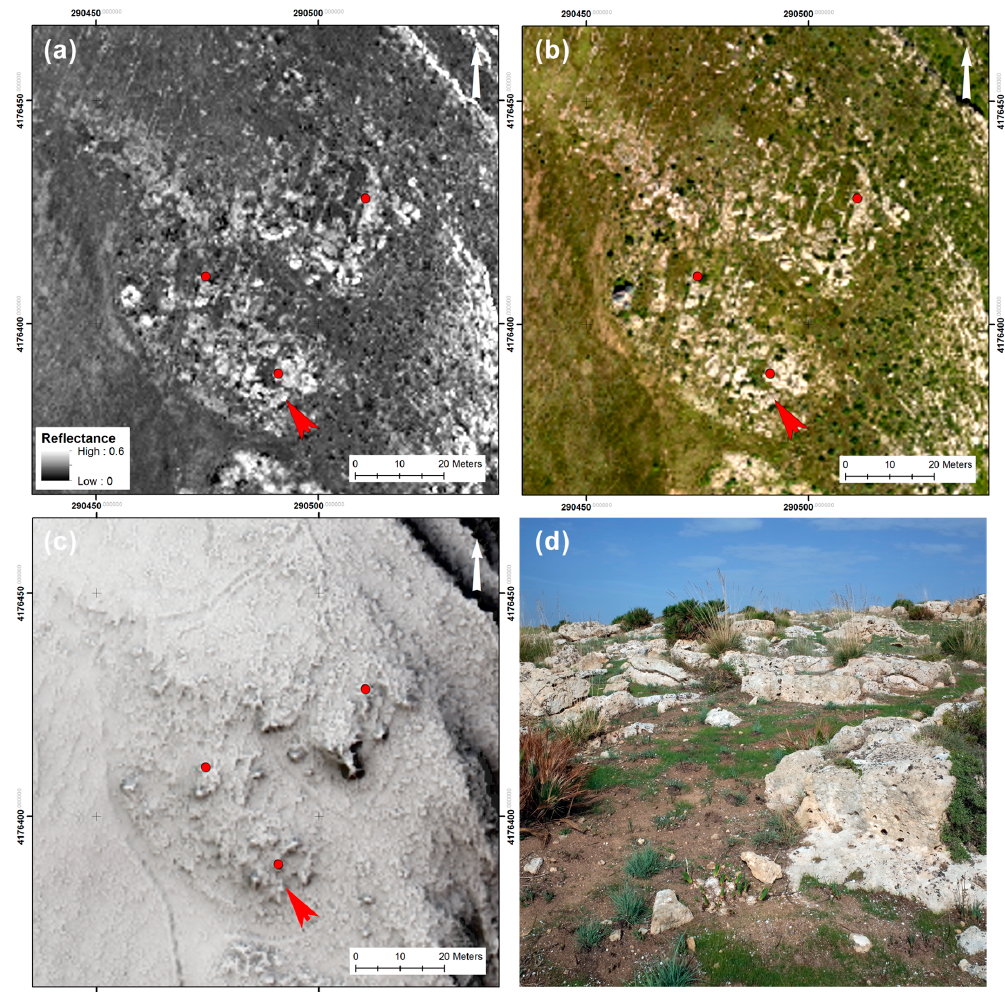
Figure 10. Rock-cut structure foundations (representative structures are to the left of red dots). ( a ) Contrast stretched calibrated reflectance image of rock cut structures, which can be identified as more homogenous rectangular objects amongst the bedrock outcrop; ( b ) contrast stretched RGB orthoimage; ( c ) multiple visualization (Multi hillshade, Slope, Sky-view factor, positive openness) of a 50 cm spatial resolution digital terrain model (DTM) specifically filtered to preserve archaeological structures; ( d ) ground image of one of the rock-cut structure foundations (position indicated by red arrows). Coordinate system ( a – c ): WGS84 UTM zone 33N. Photograph ( d ): C. Sevara. Additionally, the reflectance values clearly delimit the extensive groups of animal-drawn vehicle ruts that crisscross the exposed bedrock in our project area (Figure 11). These anastomosing networks are relicts of the former landscape infrastructure in the region, and serve as important indicators of trade, transport, and other movement throughout the area. While such networks have been extensively studied in other areas, such as Malta and the Azores [45–47], their history has yet to be explored in western Sicily. Although the route relicts sometimes reach lengths of over 100 m, the individual tracks do not always manifest in terrain-derived visualizations of the ALS data, possibly due to a combination of effects that include their narrow feature dimensions (individual tracks have widths of approx. 50 cm and depths of up to approx. 60 cm), filtering and interpolation of the elevation models. Some are shallow and appear to have been less frequently used, while others are set much deeper into the bedrock. Furthermore, they are often filled with soil and/or emergent